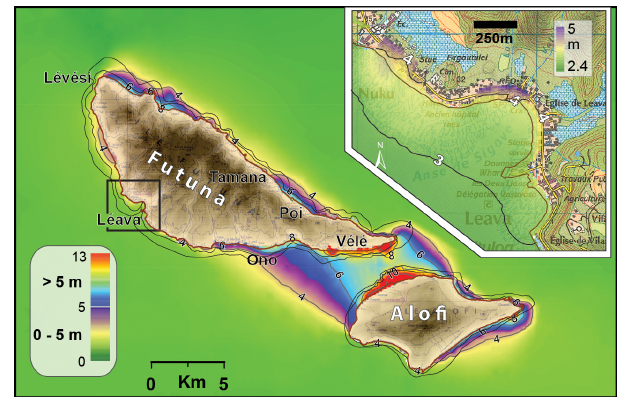
Figure 17. Synthesis of all maximum wave elevation models (in m) at Futuna and Alofi for the 15 scenarios generated for this study. Insert: focus on the Bay of Léava showing tsunami amplification on the administrative